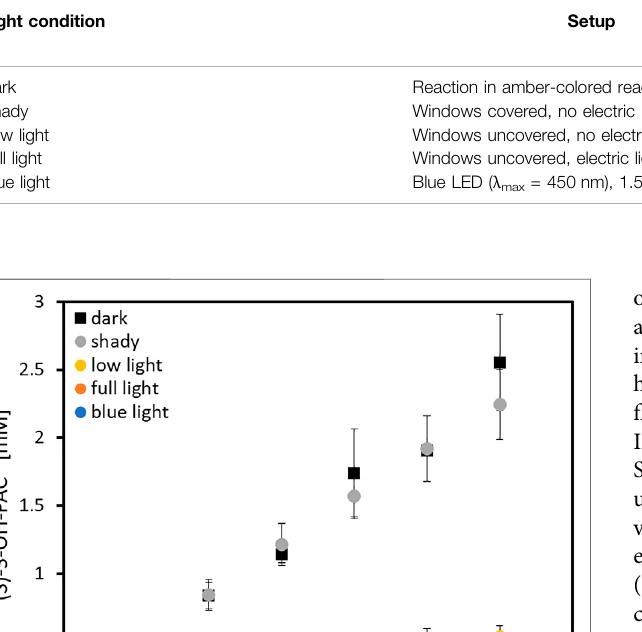
stirred quartz-glass cuvette (illuminated setups). The error bars describe standard deviation of technical triplicates.